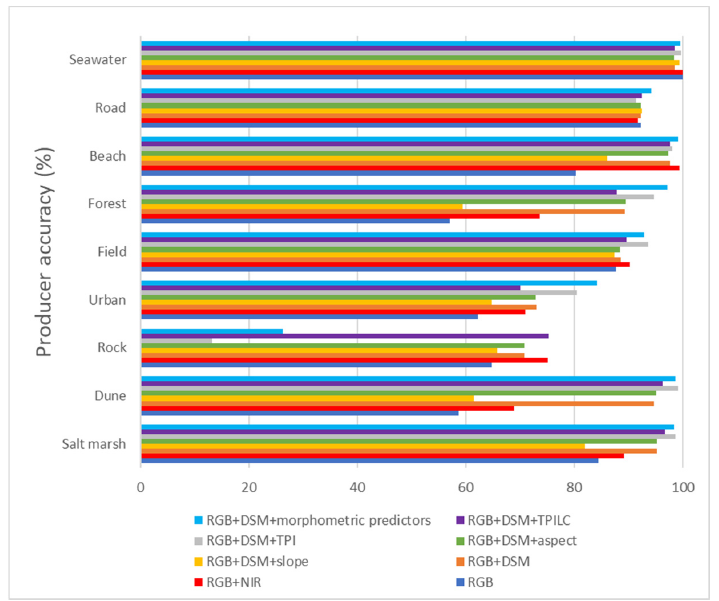
Figure 11. Bar plot of the producer accuracy of the morphometric predictor on the basis RGB at the class level (salt marsh, dune, rock, field, forest, beach, road, and seawater).